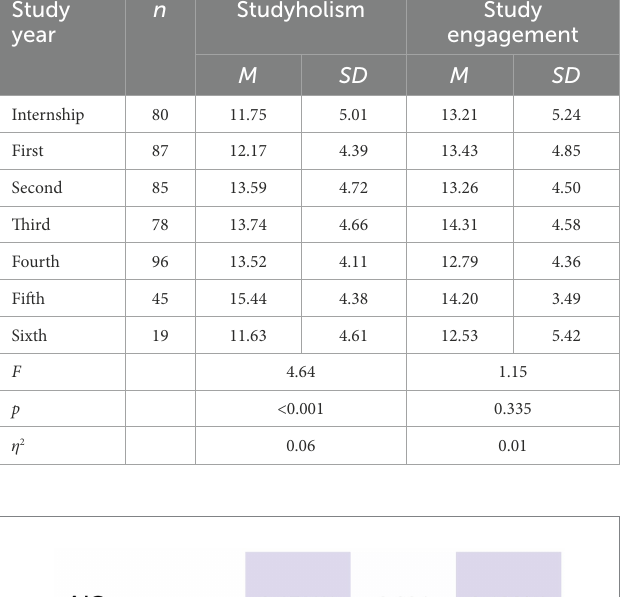
TABLE 5 One-way ANOVA for differences in studyholism and study engagement between students representing various study years ( N = 495).